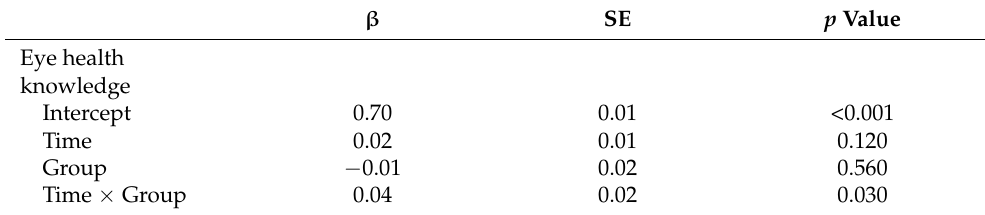
Table 5. Multivariate analysis of parents’ eye health parenting knowledge, beliefs, cues to action, parenting efficacy, and parenting